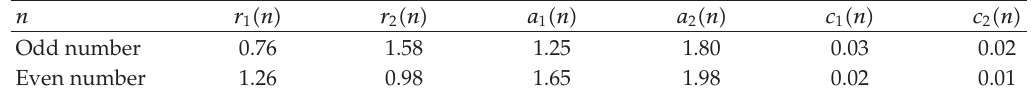
(cid:6) 0 (cid:7) (cid:8) 0 . 01 for n ∈ (cid:2) 0 , 50 (cid:3) . (cid:6) b (cid:7) Time series of x Figure 3: (cid:6) a (cid:7) Time series of x ∗ with x ∗ 2 2 and x 2 for n ∈ (cid:2) 0 , 50 (cid:3) in the same coordinate system. n ∈ (cid:2) 0 , 50 (cid:3) . (cid:6) c (cid:7) Time series of x ∗ 2 Table 1: The coe ffi cient values when n is under di ff erent